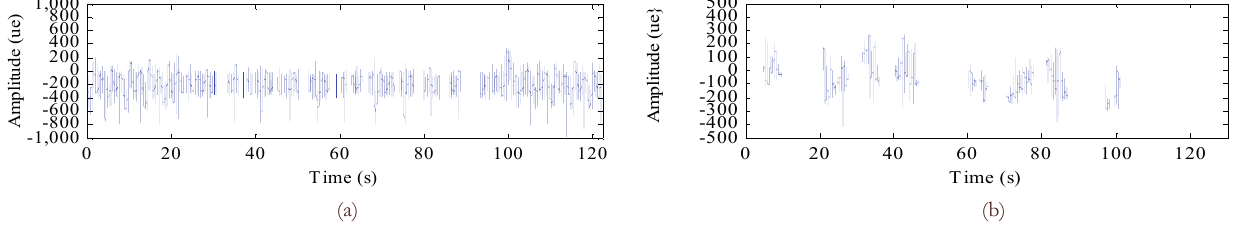
Figure 4: The location of the retained segments; (a) SAESUS, (b)